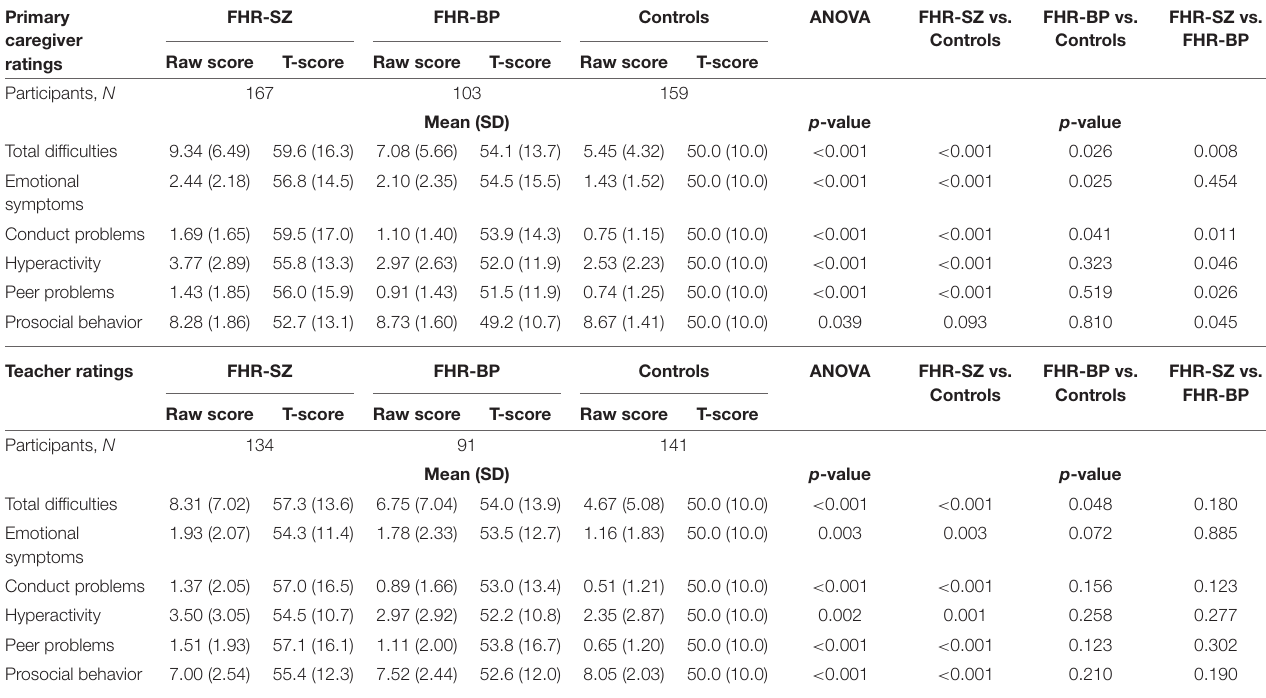
TABLE 2 | The strengths and difficulties questionnaire descriptive mean scores and standard deviations of participating children from the VIA 7 study. Primary caregiver